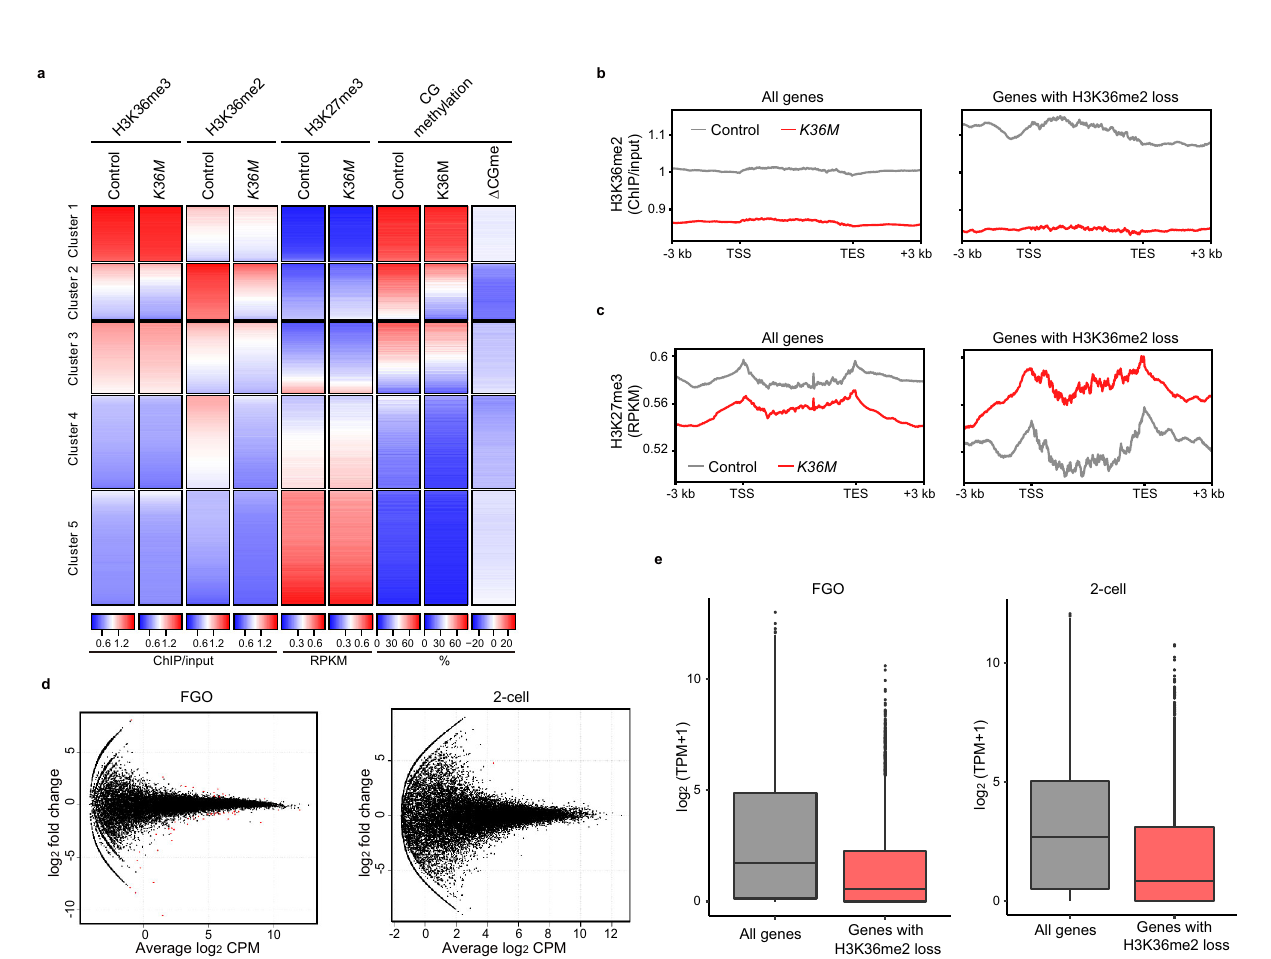
Fig. 2 | Loss of H3K36me2 causes CG hypomethylation in MMRs of FGOs. a Representative imagesofcontroland K36M FGOsimmunostainedforH3K36me2 (left) and plots showing their signal intensities (right). Expression of HA-tagged H3.3K36M (H3.3K36M-HA) was con fi rmed by HA immunostaining. Signal intensity wasmeasuredinthecontrol( n =10)and K36M FGOs( n =10)fromtwoindependent experiments. Scale bar, 10 μ m. P -values (two-tailed Mann – Whitney U tests) are indicated. Error bars indicate the mean±SD. Source data are provided as a Source Data fi le. b Heatmaps showing genome-wide H3K36me2 (left) and H3K36me3 enrichment(right)in10kbbinsincontroland K36M FGOs.Enrichmentvalueswere normalized using the spike-in control. c Genome browser snapshots showing H3K36me2 and H3K36me3 enrichment and CG methylation in control and K36M FGOs. A representative region on the X chromosome. CG methylation is lost upon H3K36me2 depletion in the regions highlighted in violet. The enrichment values were ChIP/input. d Scatter plots showing CG methylation levels in control and K36M FGOs.Fifty thousand randomly selected 10kbbins were plotted with a color